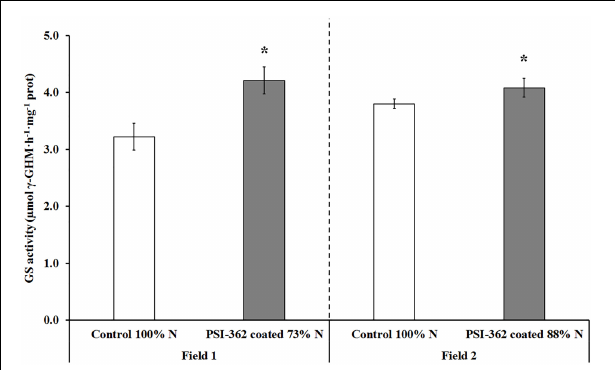
FIGURE 6 | GS activity in spring barley shoot tissue (cv. Gangway). The effect of PSI-362 coated CAN + S fertilizer on GS activity was evaluated in shoot tissue 22 days after application. Field 1: Barley crop grown in the field 1 under 73% N recommended fertilizer rate. Field 2 : barley crop grown in the field 2 under 88% N recommended fertilizer rate. Results in treated plants were benchmarked against untreated plants growing under 100% N fertilizer rate. Means followed by asterisk within the same field indicate significant differences between control and the PSI-362 treatment based on t -test at p ≤ 0.05. Number of biological replicates ( n ≥